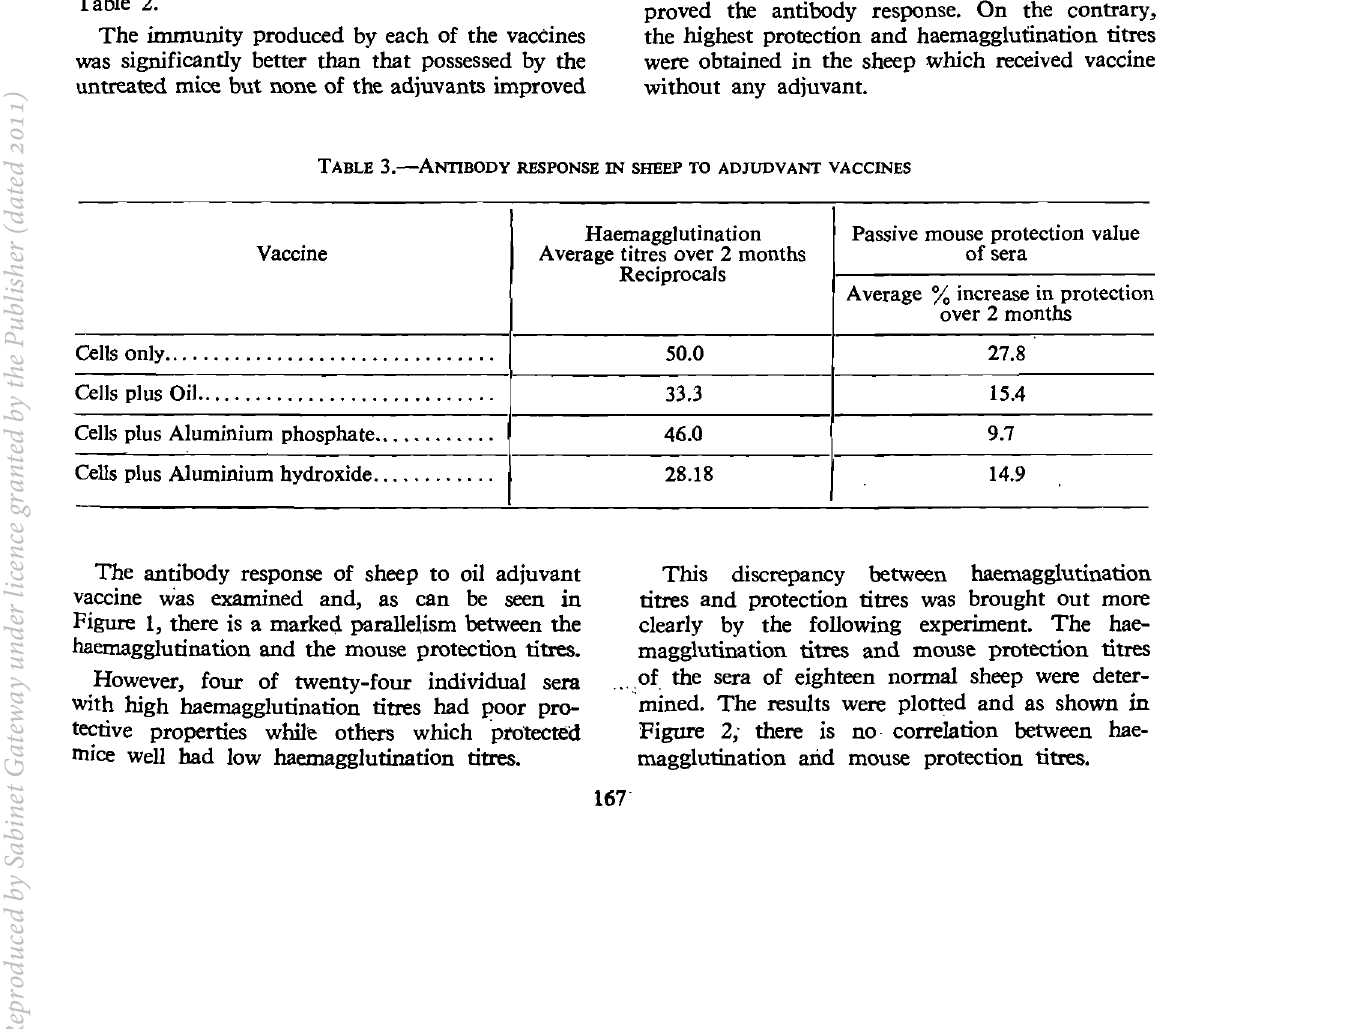
TABLE 3.-ANTIBODY RESPONSE IN SHEEP TO ADJUDVANT VACCINES Haemagglutination Passive mouse protection value Vaccine